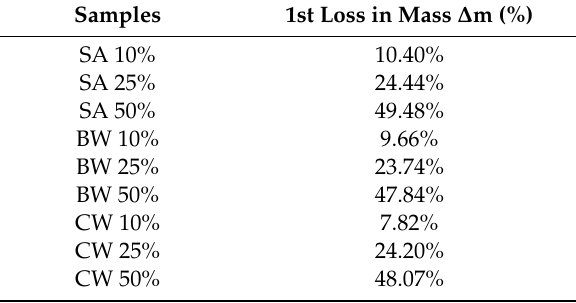
Table 2. Thermogravimetric data recorded for the first mass loss of the solid lipids (SA, BW and CW) containing 10%, 25% and 50% of carvacrol (see Table 1 for